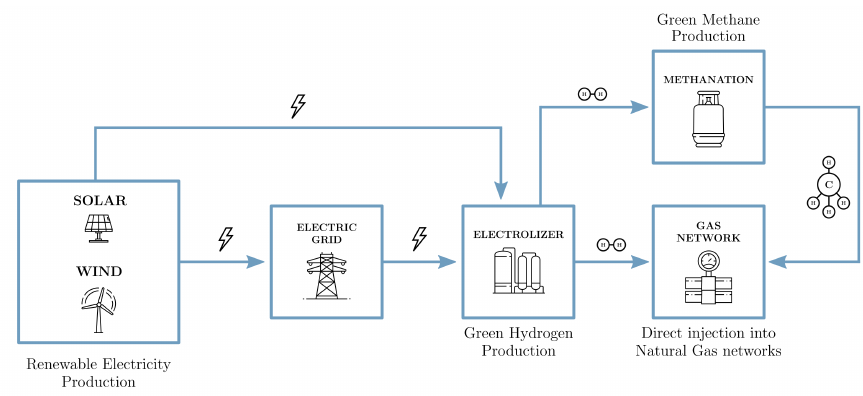
Figure 5. Flowchart of a power-to-gas hydrogen value chain configuration. Adapted from [3].